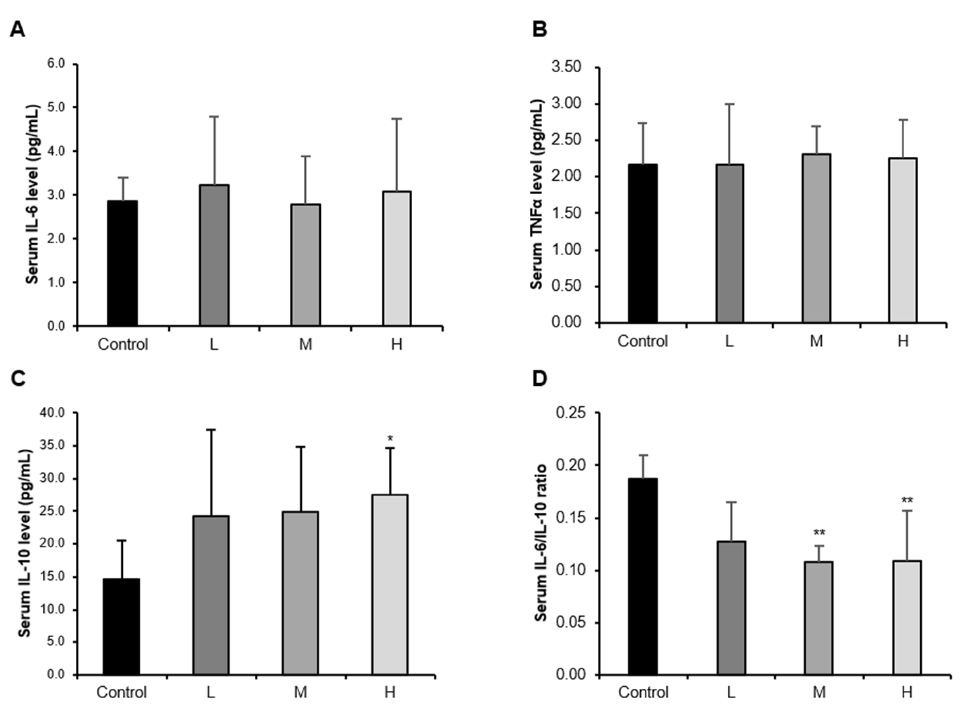
Figure 1. Effect of the GBE + WPH mixture on serum cytokine levels in aged mice. Ten-month-old male C57BL/6 mice were administered three different doses of the GBE + WPH mixture for 8 weeks; 700 mg/kg, 900 mg/kg, and 1100 mg/kg. ( A ) Serum IL-6 level measured by ELISA. ( B ) Serum TNF- α level measured by ELISA. ( C ) Serum IL-10 level measured by ELISA. ( D ) Serum IL-6/IL-10 ratio. The data are shown as mean ± SD. * p < 0.05, ** p < 0.01 versus control.